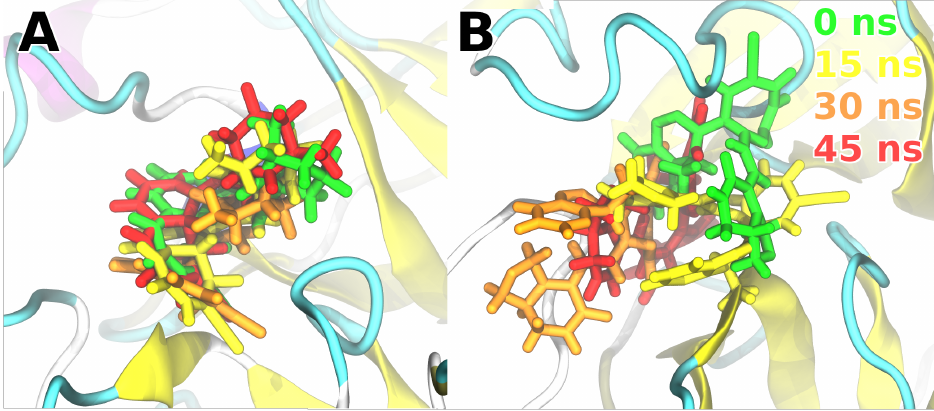
Figure A5. Position and orientation of ligand ( A ) Lig 13 and ( B ) Lig 8 in M pro at simulation time instances 0 ns (green), 15 ns (yellow), 30 ns (orange), and 45 ns (red). Lig 8 features a large RMSD value and therefore was not considered to be in a proper bound state.